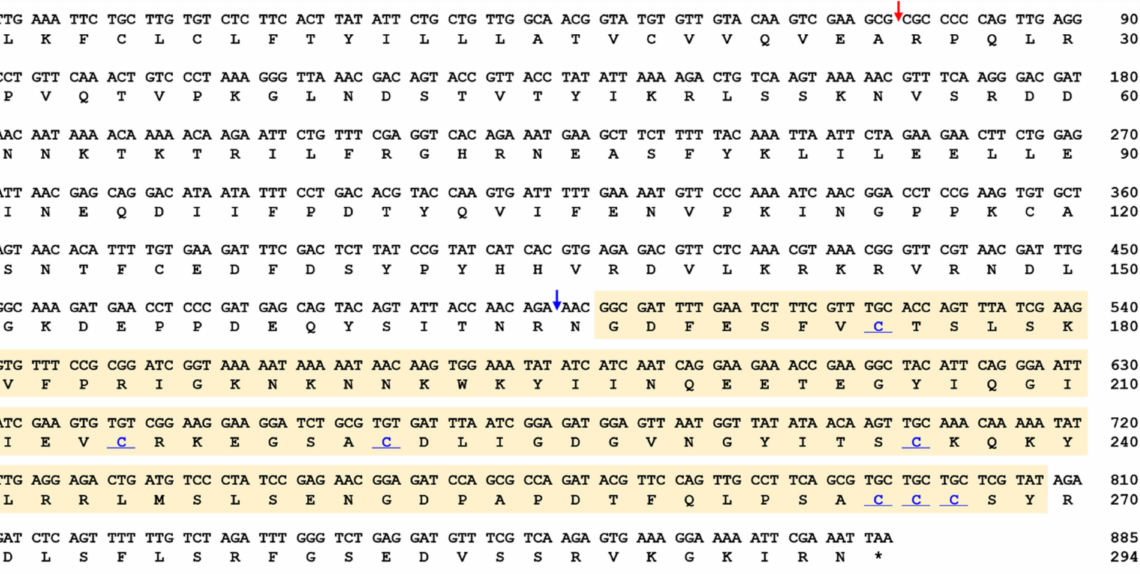
Figure 1. Nucleotide and deduced amino acid sequences of TmSpz-like . TmSpz-like contains an 885 bp open reading frame and encodes a predicted polypeptide of 294 amino acid residues. Domain analysis revealed that Tm Spz-like includes a cysteine knot domain (yellow shaded box), a signal peptide region cleaved after 25 amino acid residues (red arrow), and a cleavage site (blue arrow). The conserved cysteine residues of the cysteine knot domain forming three disulfide bridges are shown in blue font. Numbers on the right of each row represent nucleotide and amino acid